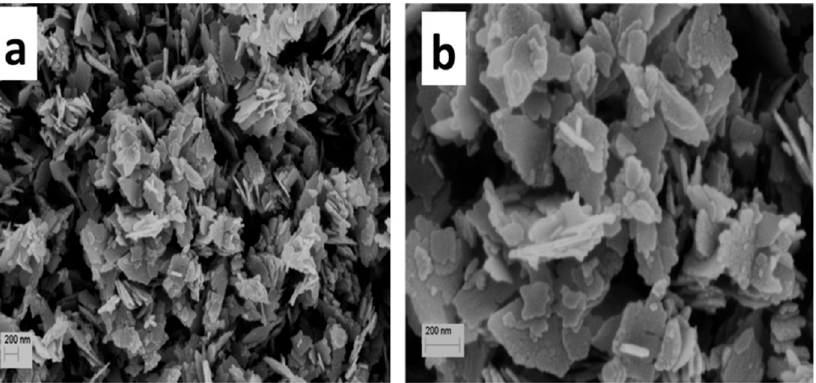
Figure 15. SEM micrographs showing the formation of the synthesized ZnO nanoflakes; ( a , b ) different magnification. Reprinted with permission from [64]. Copyright (2015) Elsevier B.V.